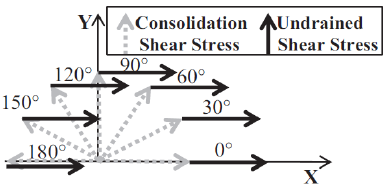
Figure 11. Stress paths on soil samples including the first consolidation shear stress, followed by undrained shear [52].